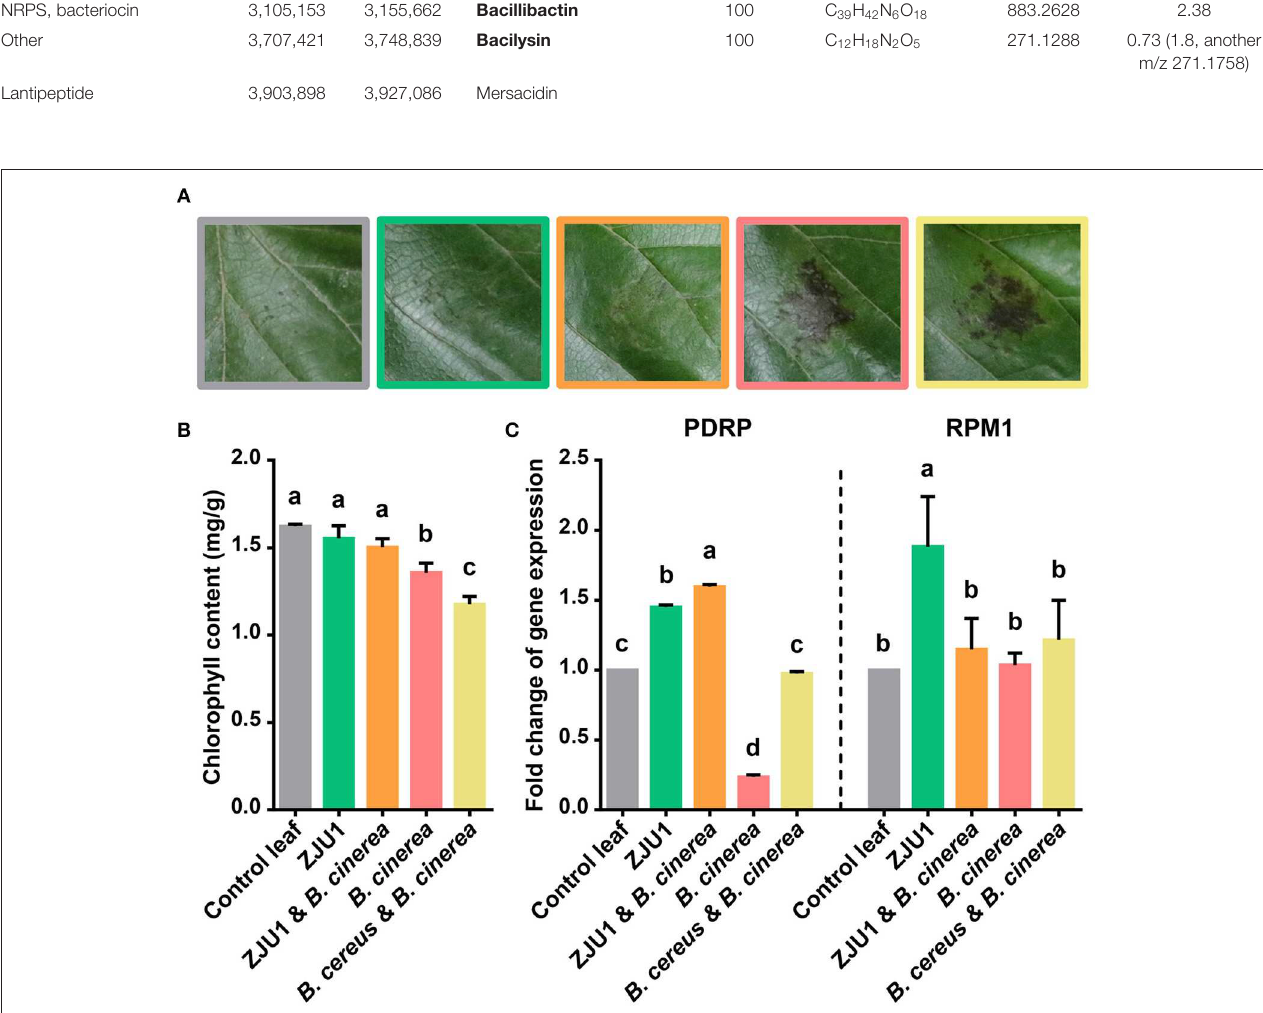
FIGURE 4 | The bacterial endophyte ZJU1 limits fungal pathogen damage in mulberry. (A) Anthracnose disease inhibition by strain ZJU1 on mulberry leaves. Representative results of at least five independent experiments are shown. Same color key as in (B,C) . (B) Leaf chlorophyll content indicating the physiological status of plants under different treatments. (C) Expression of putative disease resistance protein-encoding genes of Morus . PDRP, putative disease resistance protein SUMM2; RPM1, disease resistance protein RPM1. Different letters indicate a significant ( P < 0.05) difference between treatments by one-way analysis of variance. Error bars indicate ± SD of five